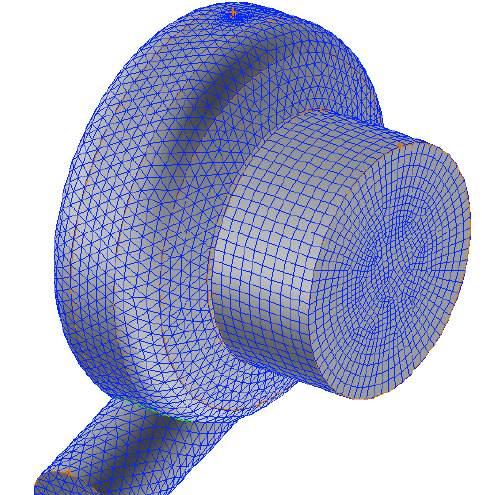
Fig. 2-2. Mesh of the model .